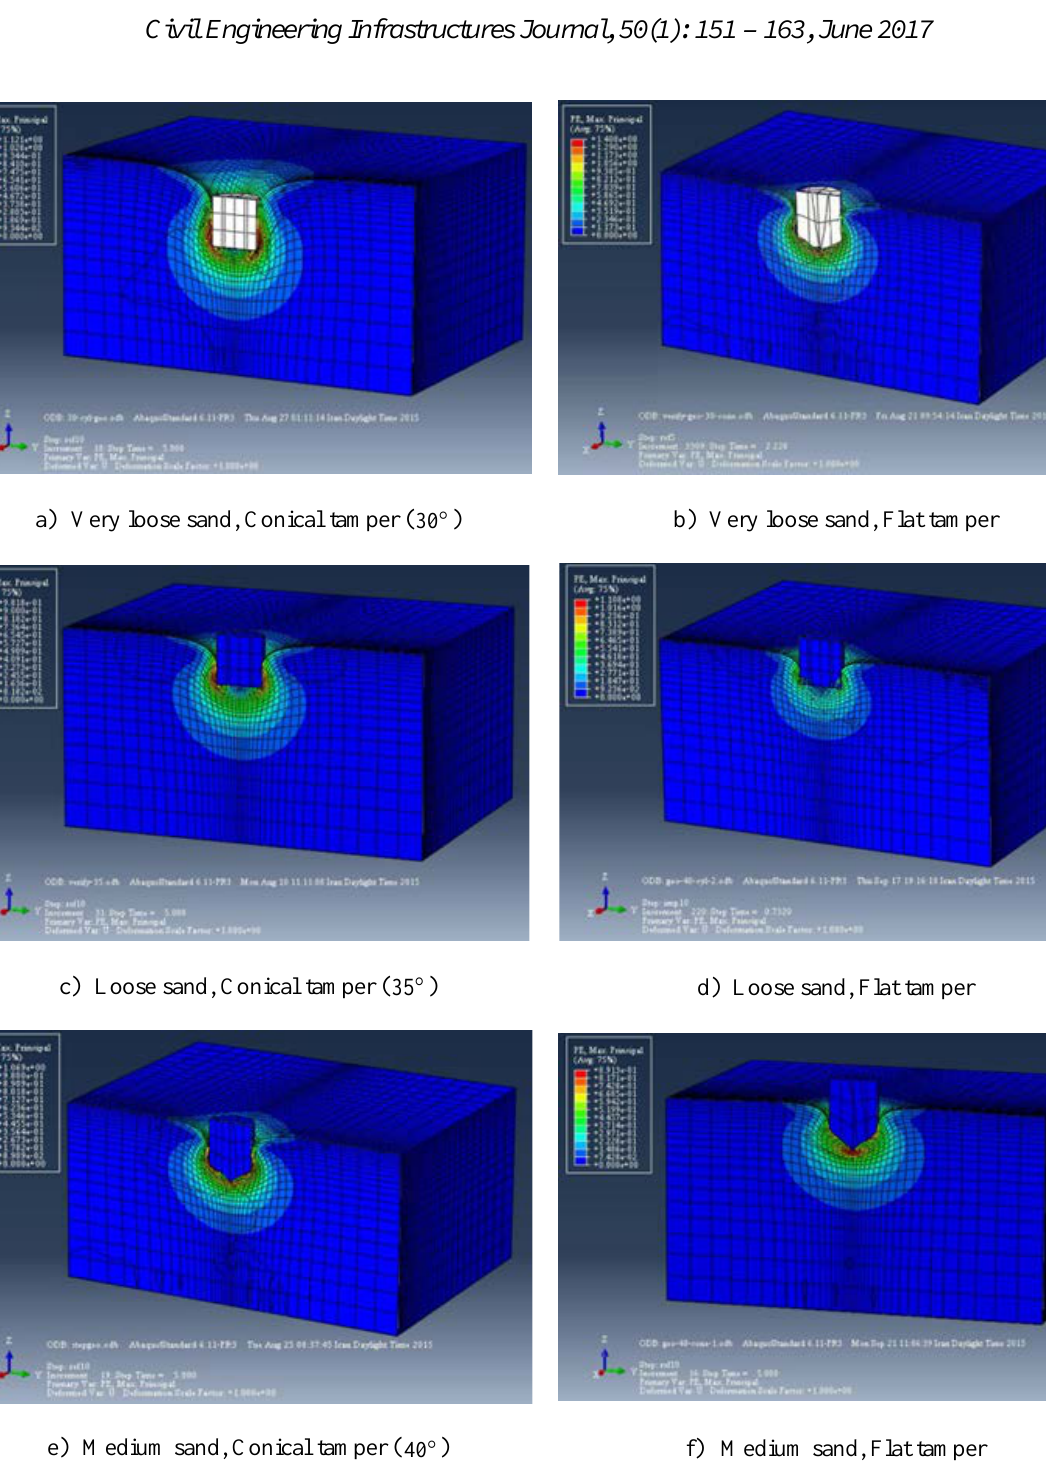
Fig. 4. Contours of maximum principal strain for 5 th blow count in numerical models of experiments conducted by Arslan et al.